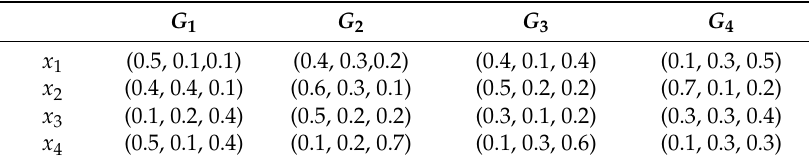
Table 4. The new picture fuzzy decision